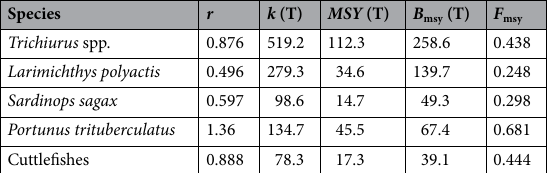
Table 4. Parameters r (intrinsic growth rate), k (carrying capacity), F msy , B msy , and MSY of selected species.